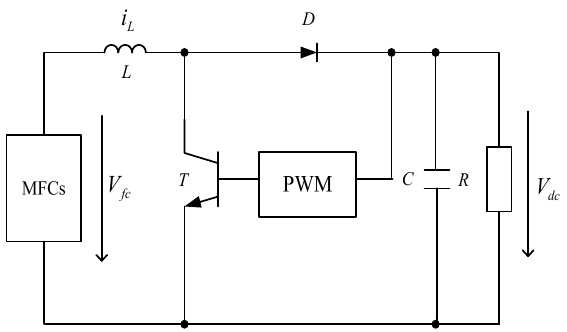
Figure 5. DC/DC converter circuit in grid-connected microbial fuel cell reactor.